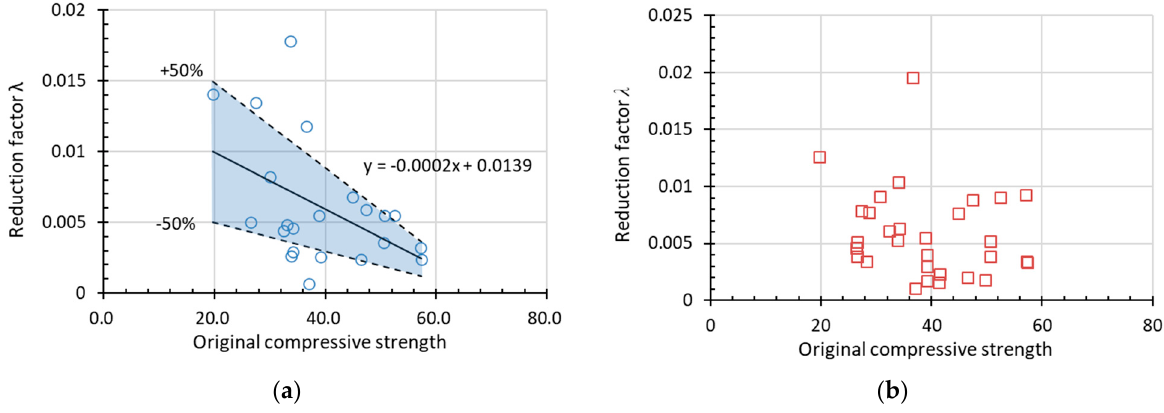
Figure 18. Factor λ in the linear function in terms of original compressive strength for ( a ) RDEM and ( b ) Rf c of non-air-entrained concrete.